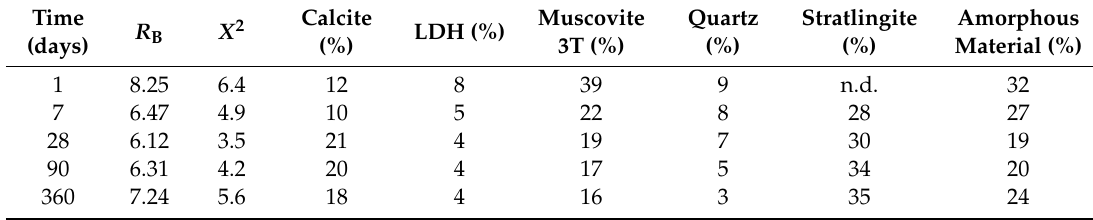
Table 5. Rietveld quantification in kaolin / lime systems at 600 ◦ C / 2 h.